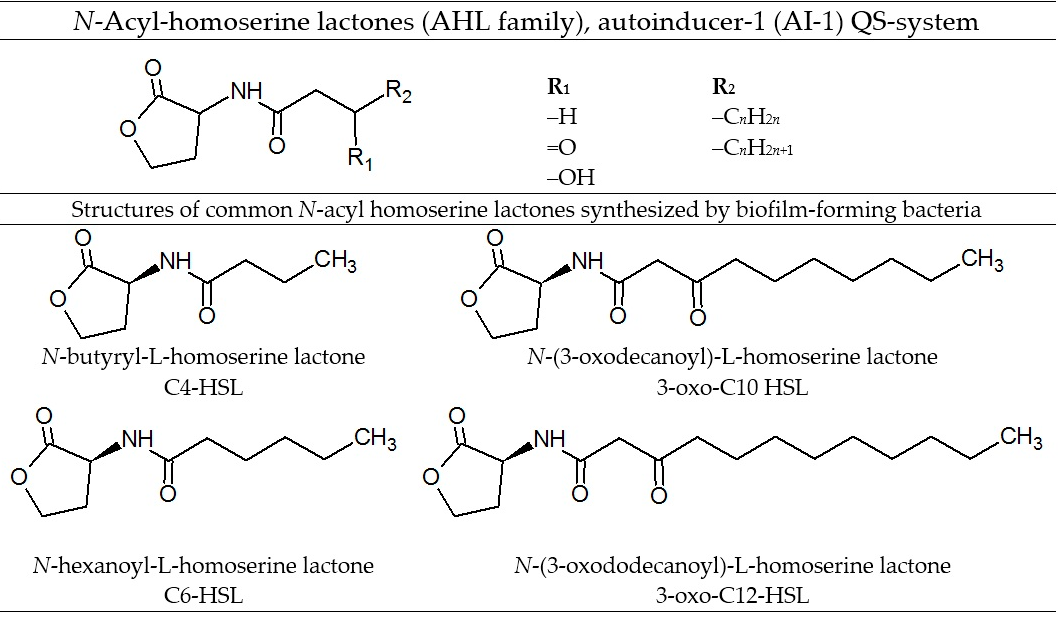
Figure 2. Chemical structures of N ‐ acyl homoserine lactones identified in the QS system of biofilm ‐ forming bacteria.